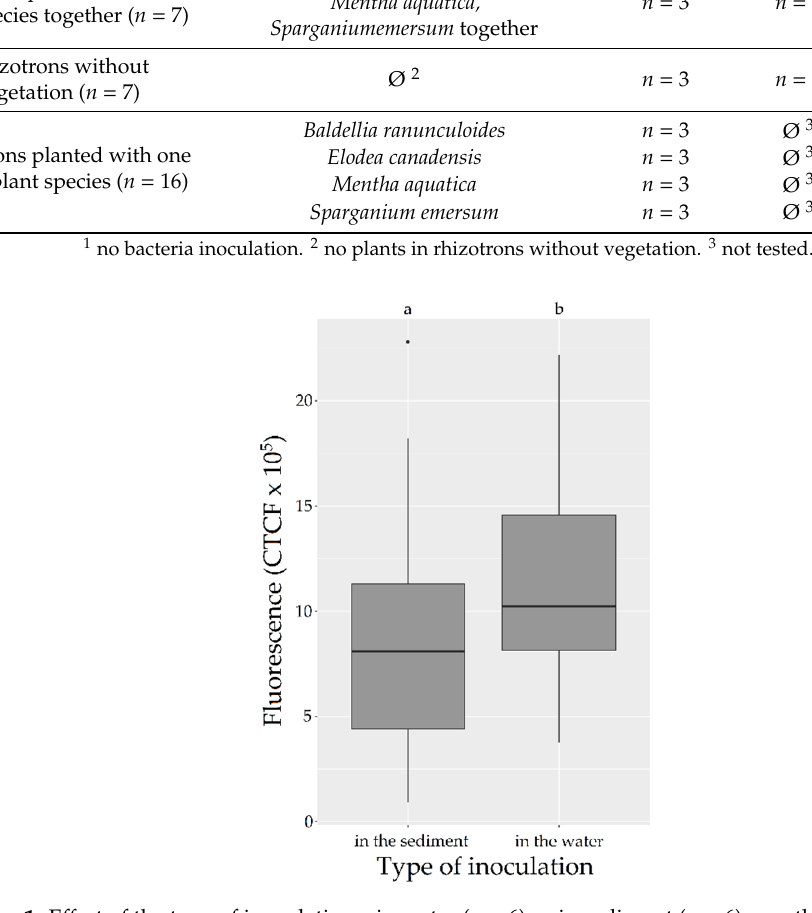
Figure 1. Effect of the type of inoculation—in water ( n = 6) or in sediment ( n = 6)—on the fluorescence of GFP- Escherichia coli in the rhizotrons. Boxplots of fluorescences measured on days 1, 2, 3, 6 and 8 (fluorescences > limit od detection (LOD)) in the water of rhizotrons inoculated with GFP- E. coli . Using an ANOVA with a multiple comparisons Tukey’s test on the l-mm, testing the effects of the type of inoculation on the fluorescence (i.e., bacterial concentration) of the water column. a and b are significantly different ( p -value (ANOVA) < 0.01). CTCF: corrected total cell fluorescence. Table 1. Experimental design. Planted and unplanted rhizotrons inoculated with GFP- Escherichia coli in water or sediment.